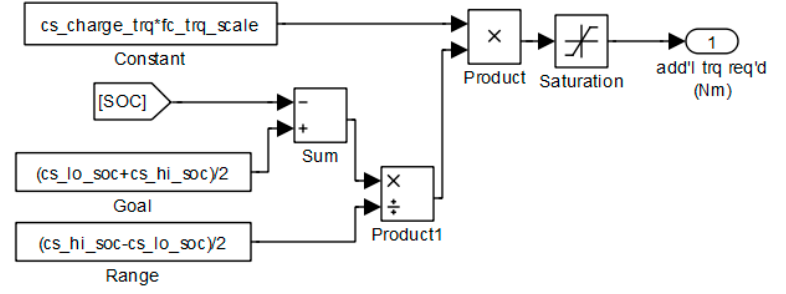
Figure 3. Engine torque for charge balance of energy storage system (ESS).